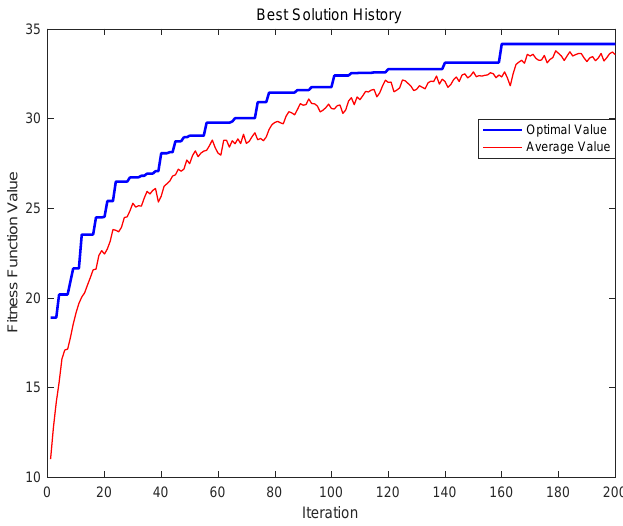
Figure 7. Evolution results of APGA with 60 attractions. Table 9. Results of the satisfaction route with APGA (60 attractions)